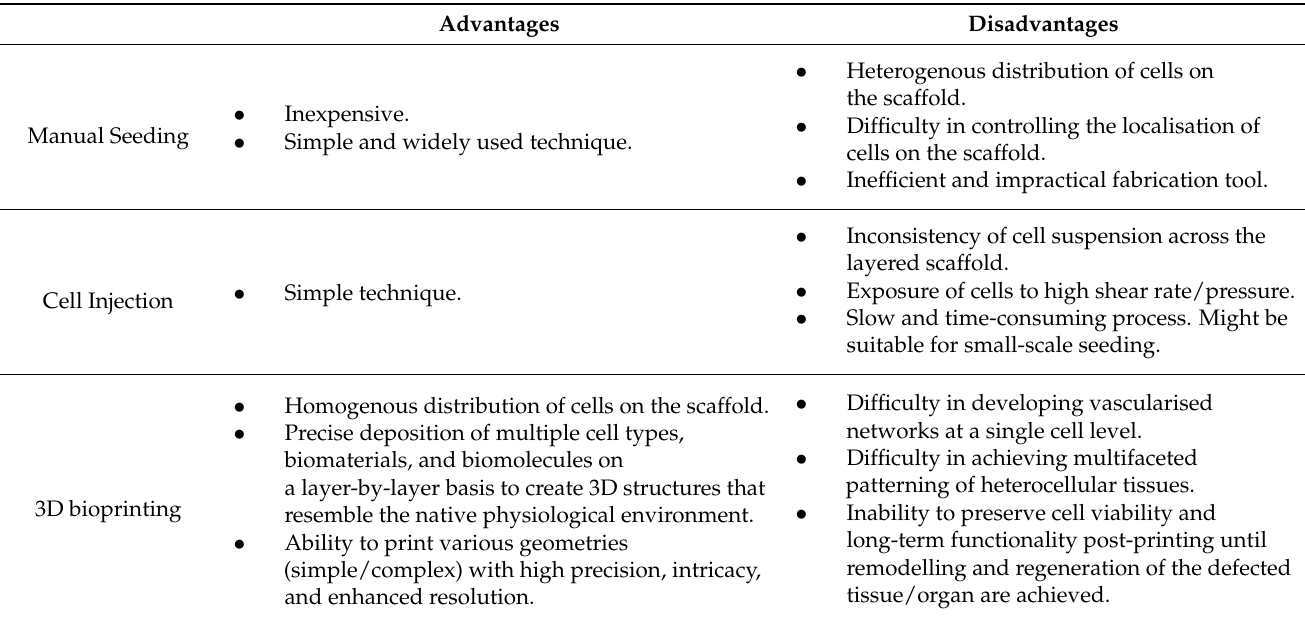
Table 2. Summary of the discussed advantages and disadvantages of different cellularisation tech- niques: manual seeding, cell injection, and 3D bioprinting. Advantages